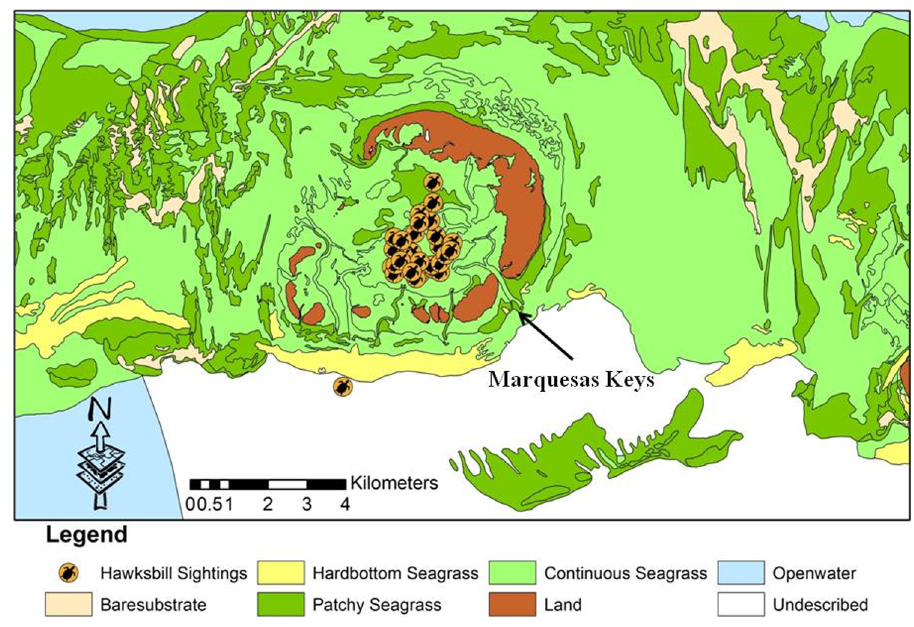
Fig. 7. Hawksbill turtle sighting locations in the western KWNWR,